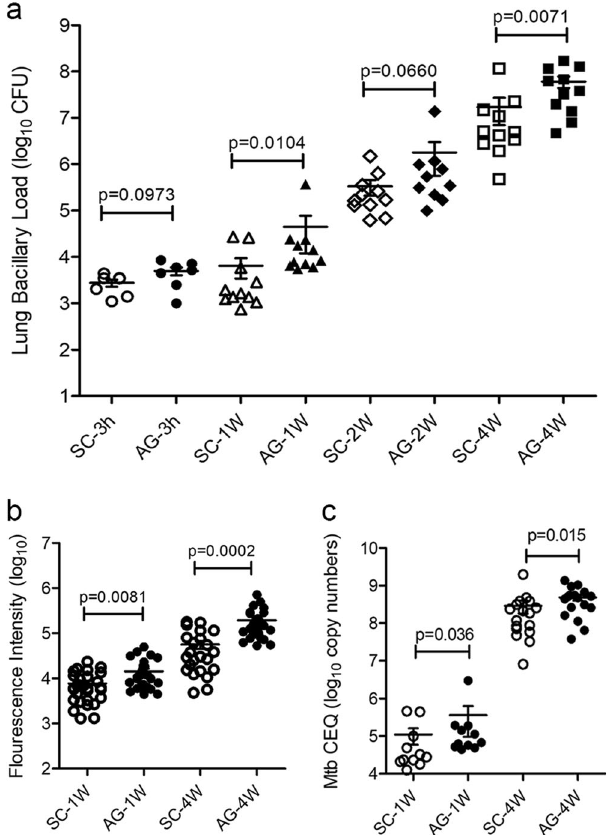
Fig. 1 Growth kinetics of Mtb-AG and Mtb-SC in rabbit lungs. a Bacillary load measured as the number of CFU in rabbit lungs infected with Mtb-AG compared with Mtb-SC at 3 h ( T = 0), 1, 2, and 4 weeks post infection. Experiments were performed with n = 6 – 11 rabbits per group per time point. p value was calculated using one-way ANOVA with Tukey ’ s post-correction for multiple group comparison. b Net bacterial load in the lung sections as quanti fi ed by immuno fl uorescence of Mtb anti-LAM antibody at 1- and 4-week post infection. Data were compiled from measuring fl uorescent intensity in 24 – 30 fi elds per lung ( n = 4 rabbits per group per time point). p value was calculated using Mann – Whitney U Test . c Total lung bacterial load estimated by Mtb-CEQ analysis at 1- and 4-week post infection. Mtb copy numbers in lung samples were determined from a standard curve developed with a known concentration of Mtb genomic DNA isolated from broth cultures. Data were compiled from n = 3 rabbits per group per time point and repeated twice. p value was calculated using Mann – Whitney U